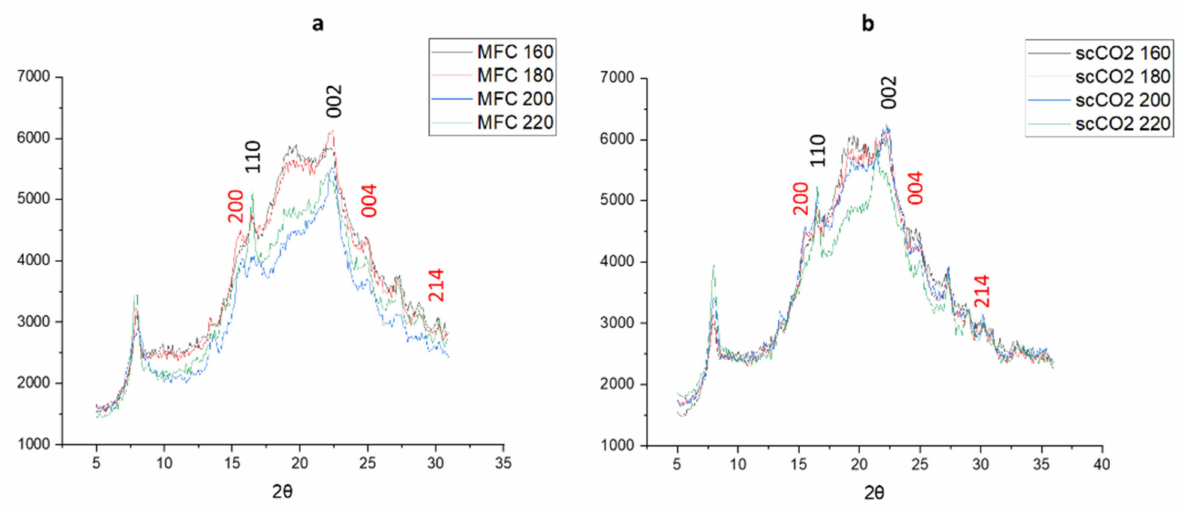
Figure 6. X-ray diffractograms of ( a ) standard method MFC and ( b ) scCO 2 method MFC. Black numbers indicate cellulose planes, red numbers indicate CaC 2 O 4 planes. NB. where ‘standard’ refers to without any scCO 2